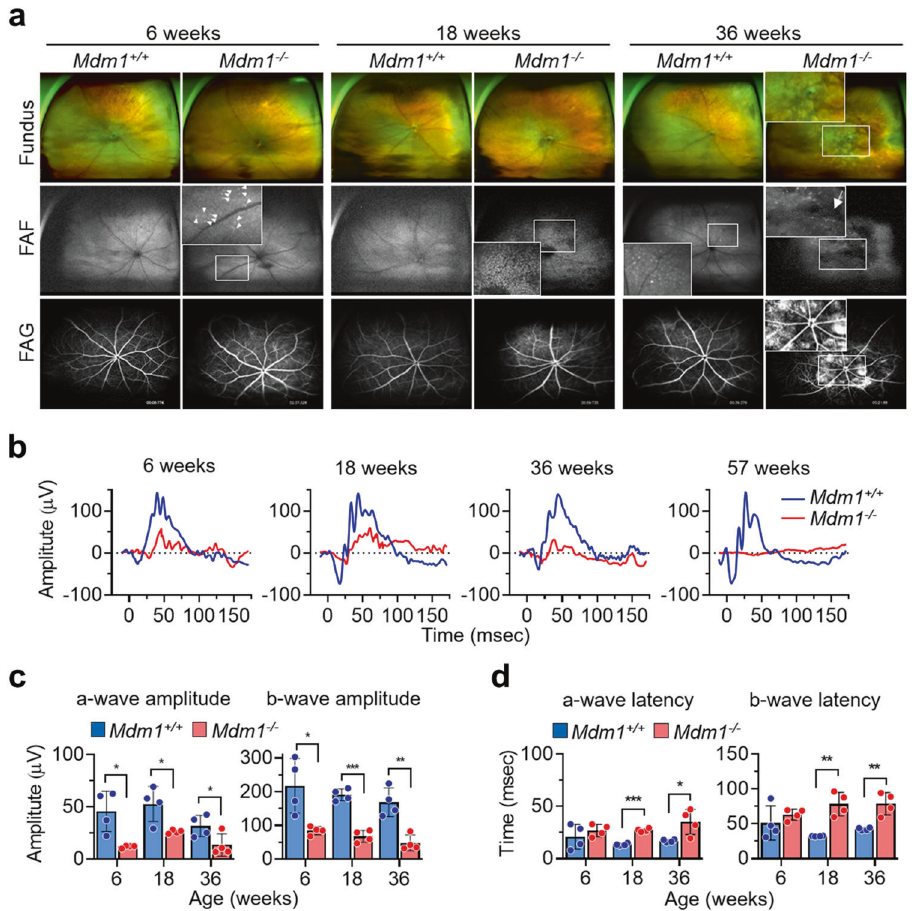
Fig. 3 Retinal phenotypes of Mdm1 + / + and Mdm1 − / − mice. a Representative fundus photographs, fundus auto fl uorescence (FAF), and retinal fl uorescein angiograms (FAG) of the retinas of Mdm1 + / + or Mdm1 − / − mice at the indicated ages. b Representative combined rod and cone electroretinograms. c Quanti fi cation of a-wave and b-wave amplitudes. d Quanti fi cation of a-wave and b-wave latencies. Values are the means ± SEM; n = 4 per group (* P < 0.05, ** P < 0.01, *** P < 0.001 by a two-tailed Student ’ s t